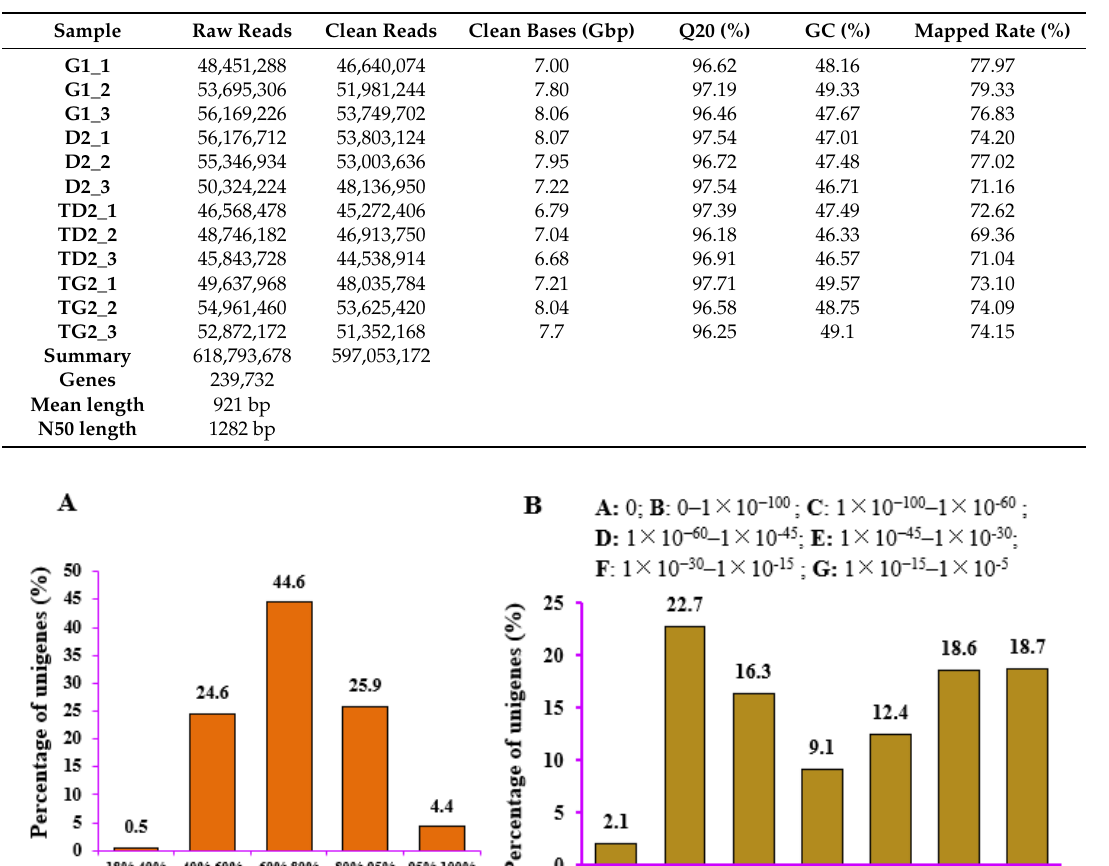
Table 1. Summary of sequences analysis.